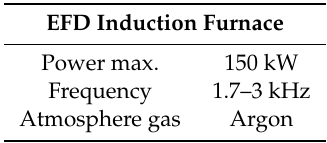
Table 2. EFD induction heating equipment characteristics.